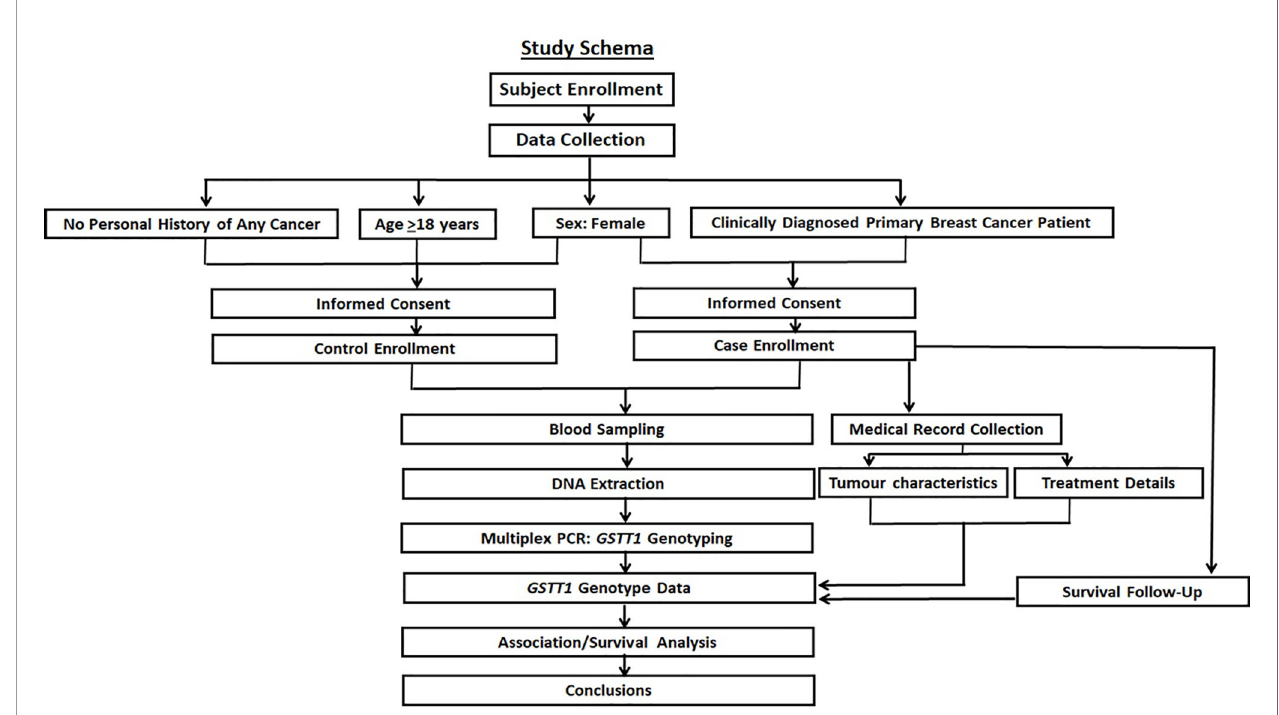
FIGURE 1 | The study schema. The prospective recruitment of cases with age-matched female controls is shown along with the collection of speci fi ed molecular, clinical, and survival data. The objective was to investigate the contribution of GSTT1 variation in breast cancer risk, tumor characteristics, and survival after standard